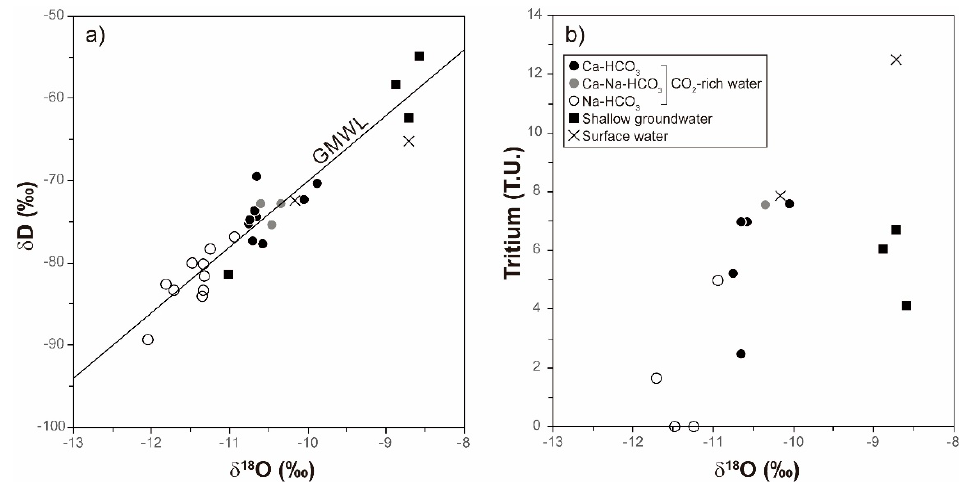
Figure 6. ( a ) Diagram of δ 18 O versus δ D values. The solid line is the global meteoric water line ( δ D = 8 × δ 18 O + 10). ( b ) Diagram of tritium versus δ 18 O.